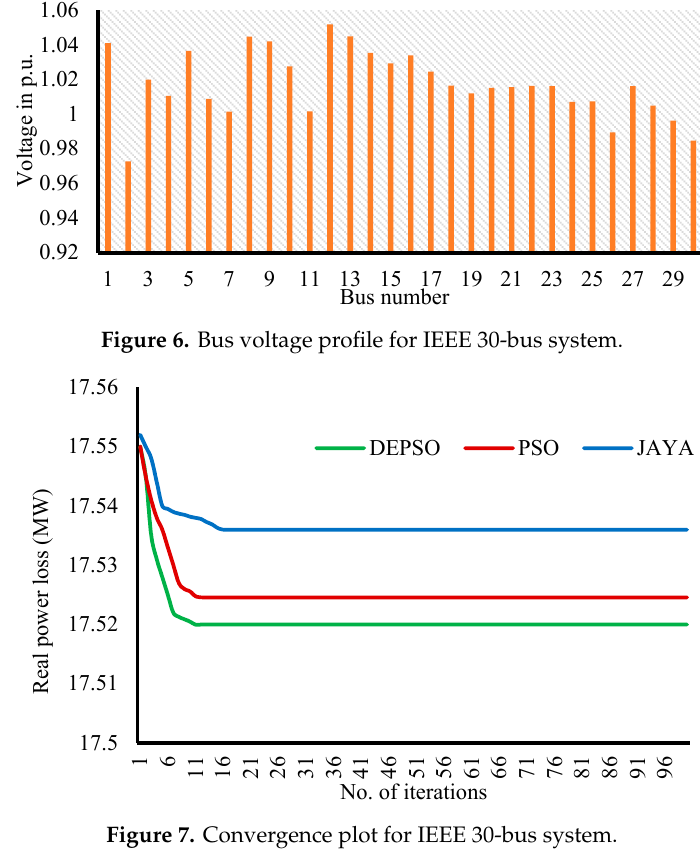
Figure 5. Power loss reduction for IEEE 30-bus system.